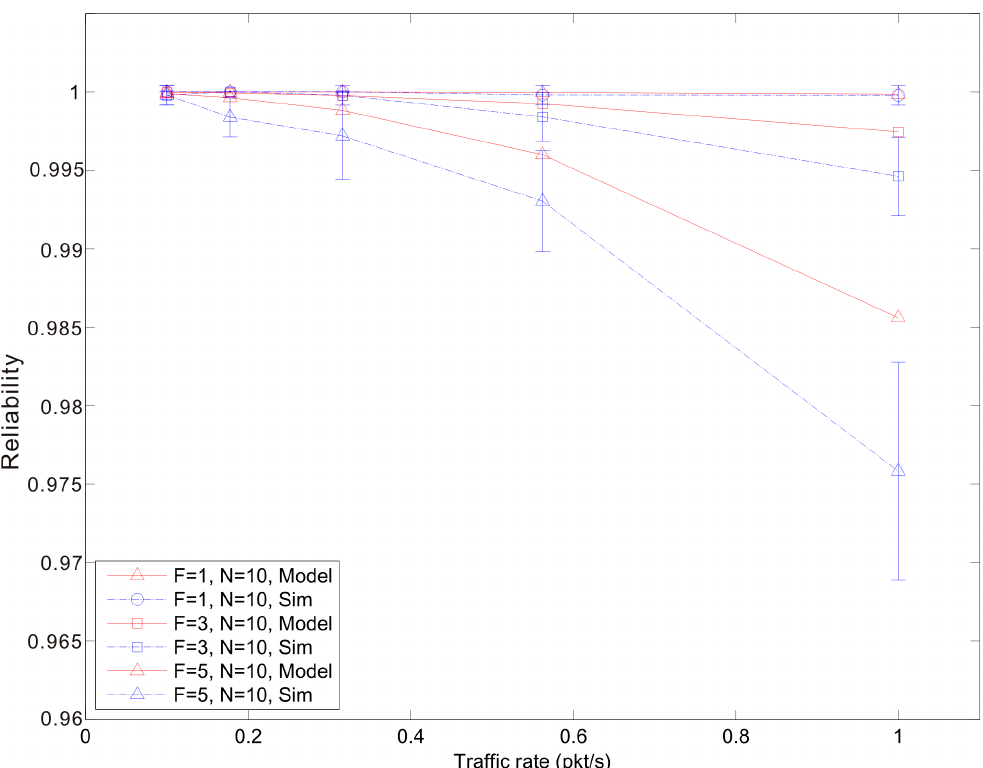
Figure 10. 6LoWPAN fragmentation reliability versus traffic rate for a star topology network composed by 10 nodes.